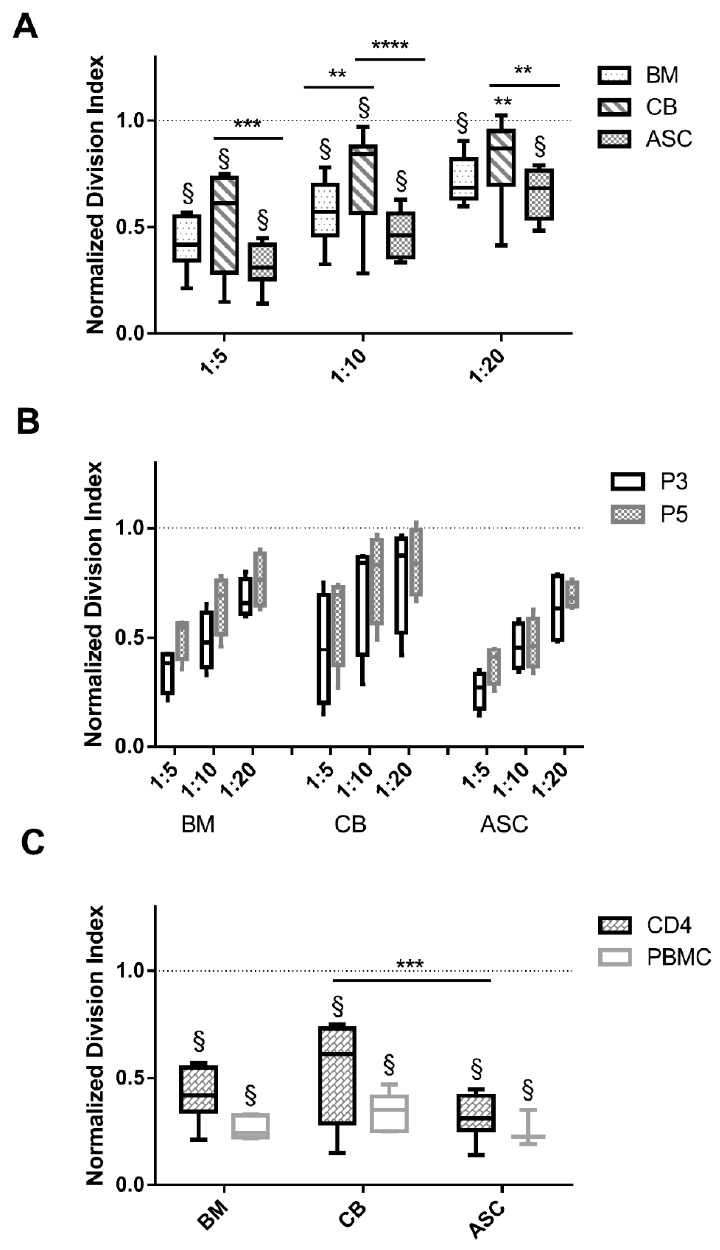
Figure 1. ASC suppress PHA-induced T cell proliferation to a stronger extent than BM or CB-MSC, independent of passage number and CD4 or PBMC population. ( A ) PBMC division index in cocultures with BM, CB and ASC in three di ff erent ratios (1:5, 1:10 and 1:20), indicates ASC as stronger immunosuppressors. ( B ) MSC inhibitory potential in P3 and P5 does not di ff er (n.s., 2-way ANOVA). ( C ) CD4 + T cell and PBMC division index is not impacted (n.s., 2-way ANOVA). Dotted lines represent the normalized division index of the positive control (only PBMC stimulated with PHA: + PHA control). Box: interquartile range; whiskers: minimum to maximum; line: median. Asterisks depicted at the top of the lines represent the significance of the individual value with respect to their own condition control (** p < 0.01, *** p < 0.001, **** p < 0.0001) Symbol § represents the significance of the individual conditions with respect to their + PHA control (§: p < 0.0001, 2-way ANOVA). n = 4 to 8, di ff erent MSC isolates and di ff erent PBMC isolates.